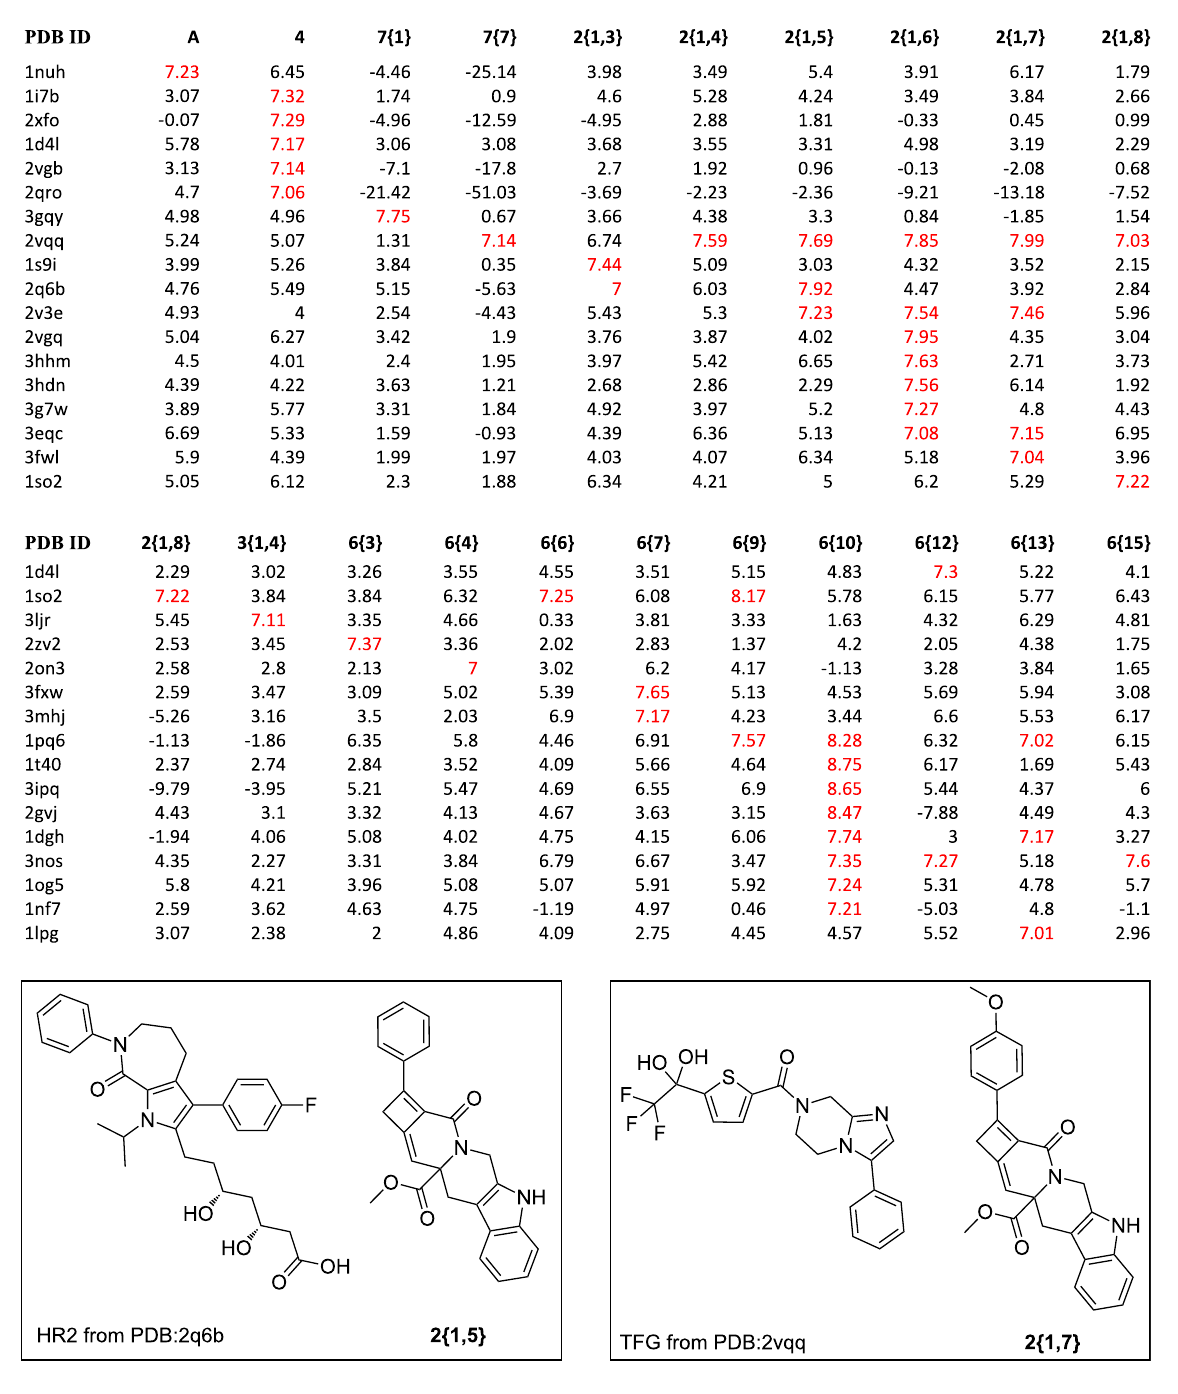
Figure 3: Results of high-throughput docking analysis. Top: A docking-score matrix arranged by compound IDs and PDB IDs; bottom: Structures of known ligands HR2 and TGF and the newly synthesized compounds 2{1,5} and 2{1,7} . Docking scores larger than 7.0 are red colored and can be mapped to K d values less than 100 nM. The corresponding protein names of PDB IDs and the full docking-score matrix are listed in Supporting Infor- mation File